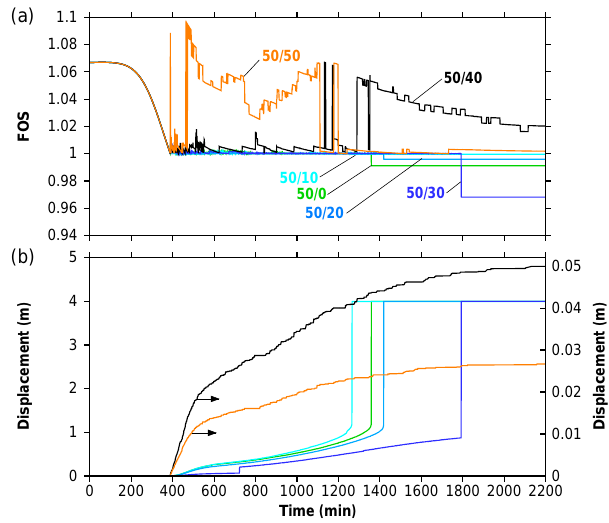
Figure 13. Time series of (a) factor of safety (FOS) and (b) dis- placement at the center of the slope ( x = 0, y = 0) for six simula- tions with different tree sizes inside the clearing. The sets of two numbers shown in panel (a) indicate the stand DBH and the clear- ing DBH in centimeters. For example, 50/10 means a stand of trees 50cm in diameter with a clearing filled with trees 10cm in diame- ter. Spacing is identical in the clearing and in the stand (3m). Color code is identical in panels (a) and (b) . In panel (b) the simulations 50/40 and 50/50 do not fail and slope displacement plots on the vertical axis on the right side (indicated by